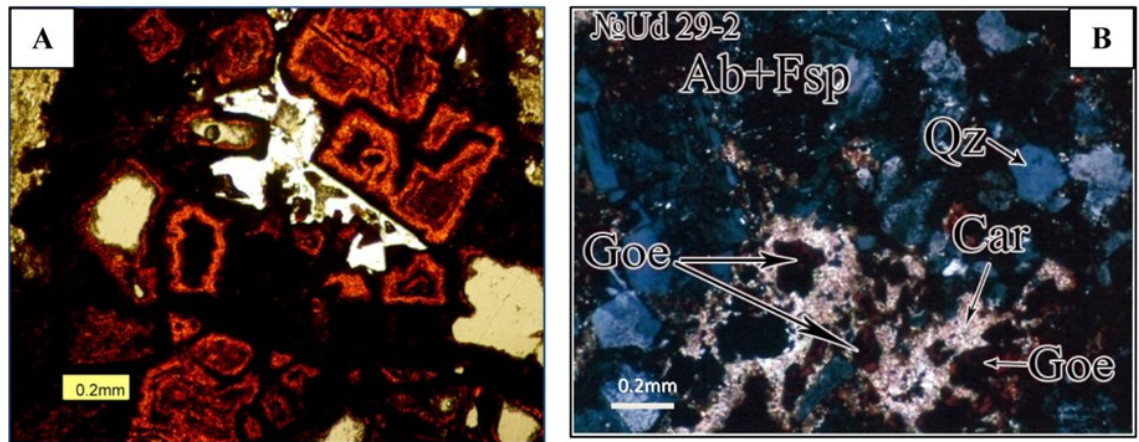
Fig. 8. A. Goethite zoned and replaced with hydrogoethite from the edge. B. Iron oxide lenses (Goe) with carbonate (Car) on albite-feldspar matrix (Ab+Fsp), Qz -quartz